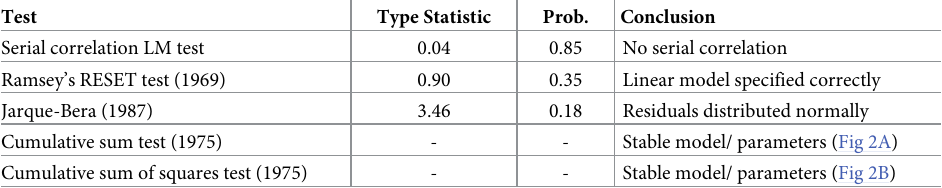
Table 9. Findings of diagnostic